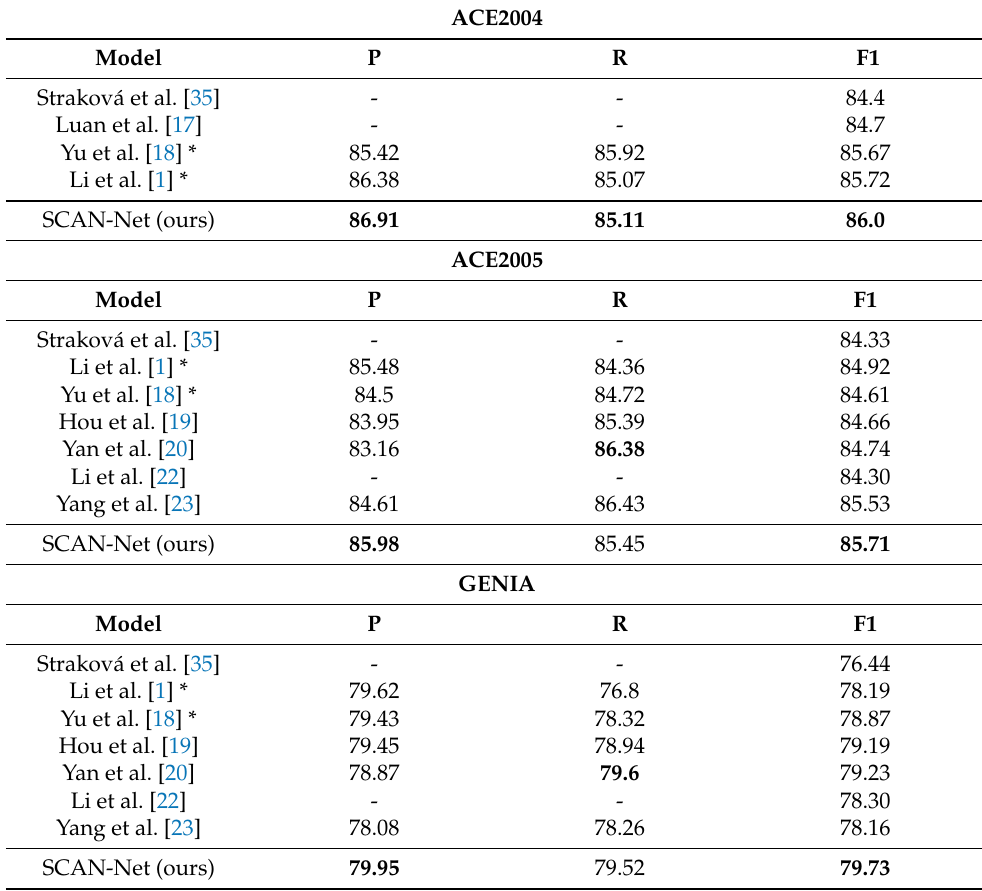
Table 4. Comparison of the performance of the ACE2004, ACE2005 and GENIA datasets. * indicates the results we achieved through their code. Bold numbers indicate the best